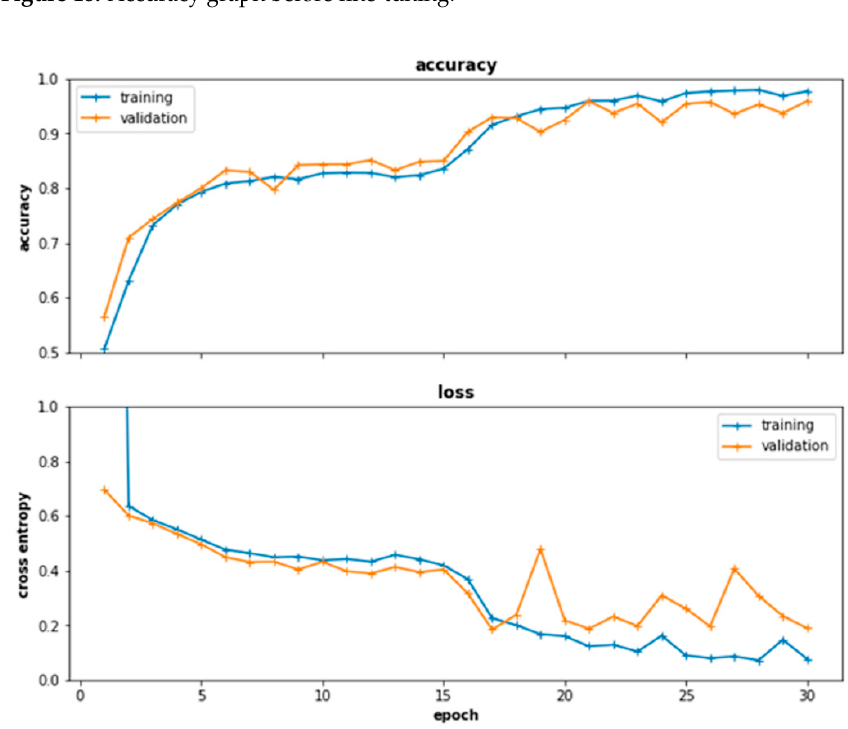
Figure 19. Accuracy graph after fine-tuning the layers. Table 9. Comparative analysis of existing models.